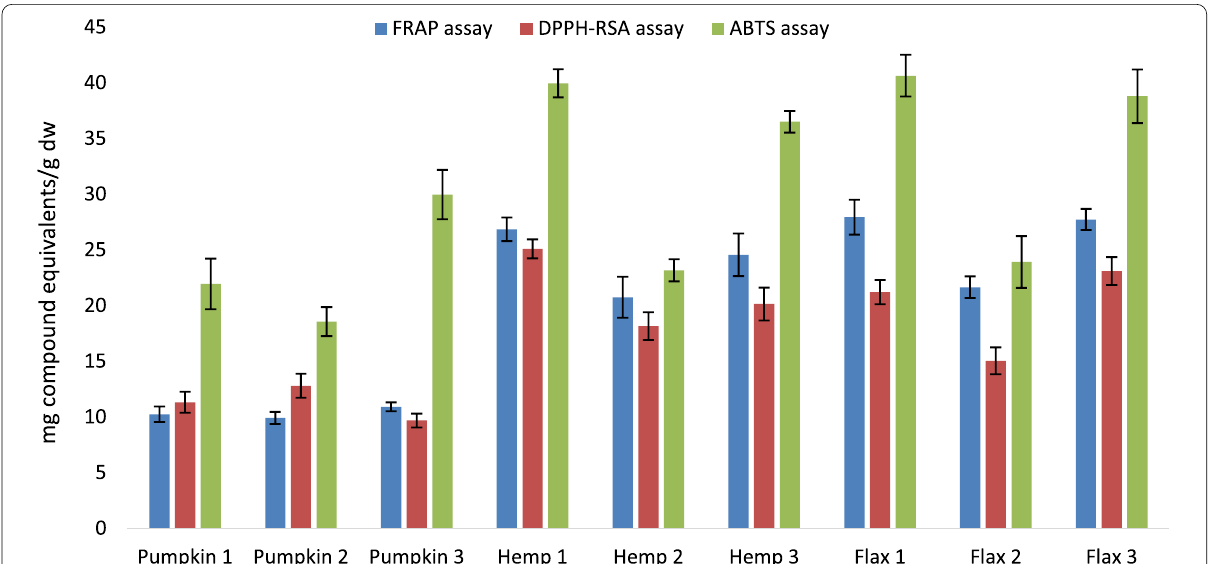
Fig. 1 Antioxidant activity of oilseed cakes extracts. Blue bars: ferric reducing antioxidant power (FRAP, results expressed in mg ascorbic acid equivalents/g dry weight); Red bars: 1,1‑diphenyl‑2‑picrylhydrazyl radical scavenging activity (DPPH‑RSA, results expressed in mg Trolox equivalents/g dry weight); Green bars: 2,2‑azinobis (3‑ ethylbenzothiazoline‑6‑sulfonic acid) diammonium salt assay (ABTS, results expressed in mg ascorbic acid equivalents/g dry weight) assays. Results are expressed as mean with a solid to solvent ratio of 1:30 (w/v), 1 h at 160 °C with (1) 20 bar N 2 , (2) 20 bar N 2 with 0.05 M HCl, (3) 20 bar CO